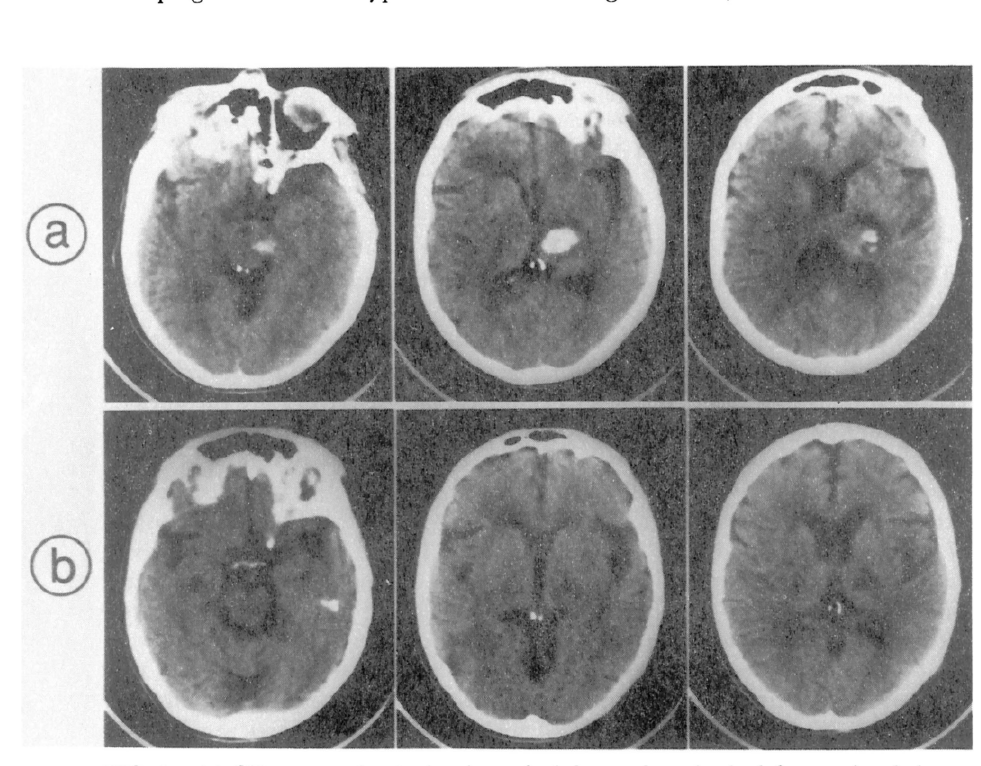
FIG. I. (a) CT scan on day I, showing a fresh hemorrhage in the left posterior thalamus and posterior limb of the internal capsule, extending into the midbrain tegmentum. (b) CT scan on day 60 with complete resolution of the hematoma, leaving only a small hypodense area in the lateral part of the thalamus and posterior limb of the internal